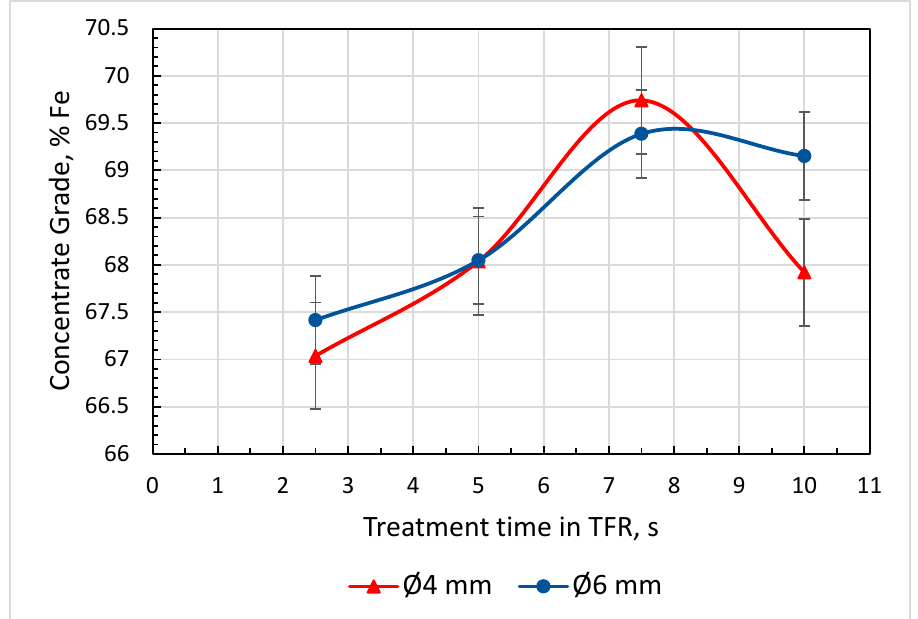
Figure 8. Dependence of the concentrate grade on suspension treatment time in TFRs having 4 and 6 mm inner diameters. CTAB dosage 20 g/t, microbubble dosage 0.21 mL/g. (Error bars represent the standard deviation obtained from 3 test repeats).